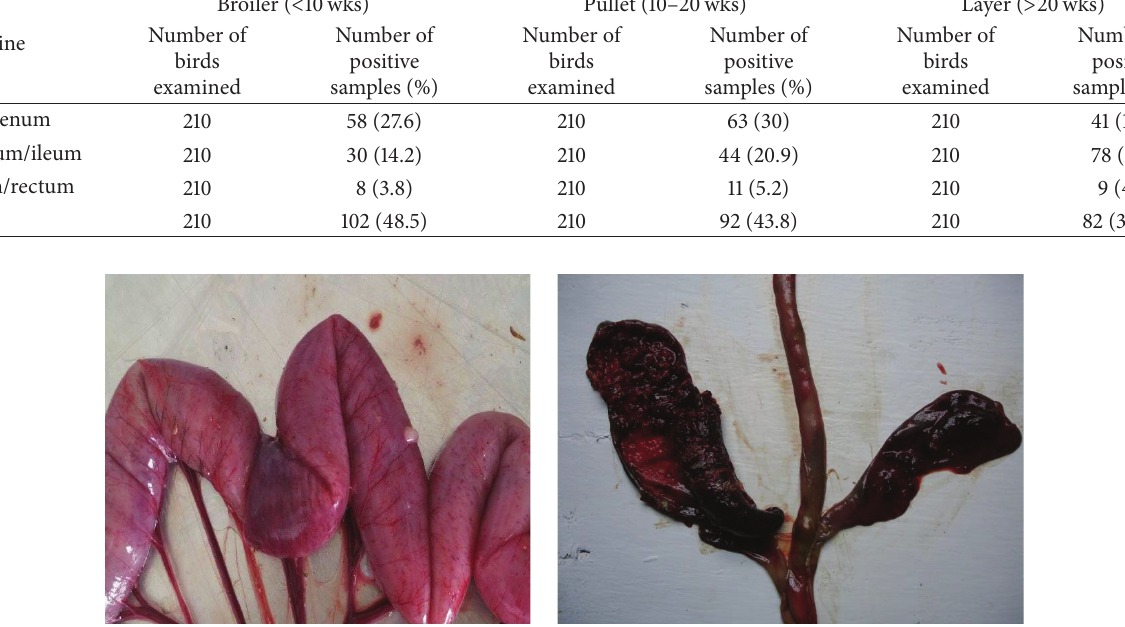
Figure 1: (a) Infected ten-week-old broiler by E . maxima (note the petechiae through the wall of the middle intestine). (b) Cecal coccidiosis in eight-week-old pullet infected by E . tenella . The ceca are distended and the wall is thickened. The erosion of the mucosa results in the accumulation of huge amount of fibrin-necrotic material noted at the opening of the